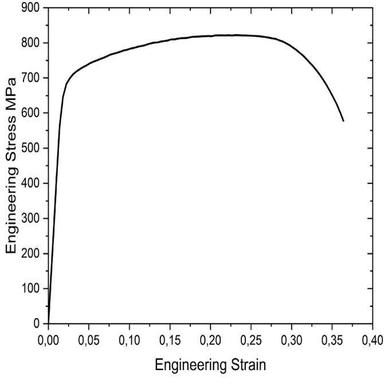
Mechanical characterization in SDSS-Nb 1090 ◦C.